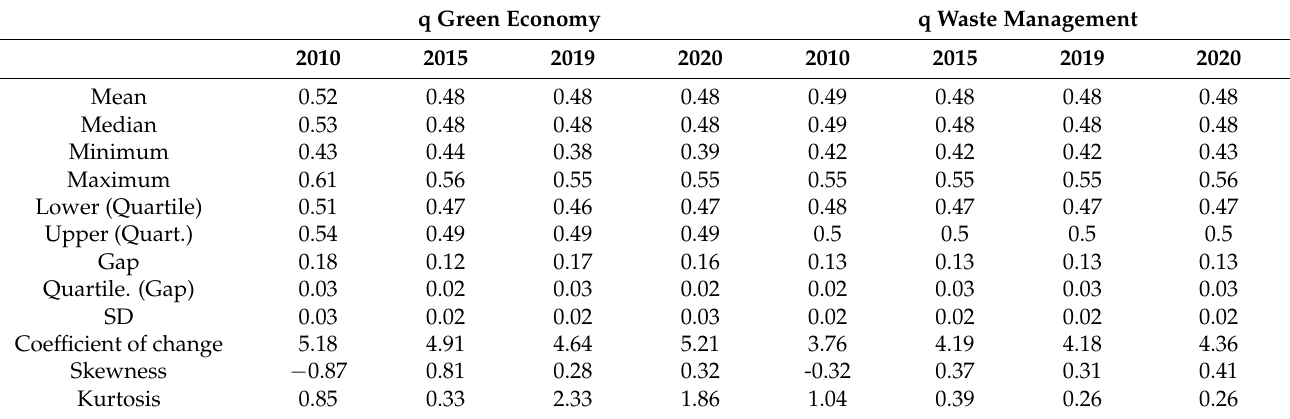
Table 6. Statistical characteristics of the synthetic measure waste management and green economy in districts in Poland (in 2010, 2015, 2019, and